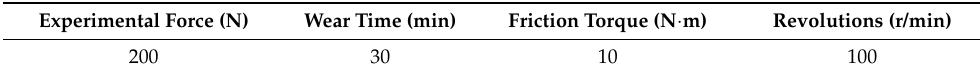
Table 2. Friction and wear parameters.